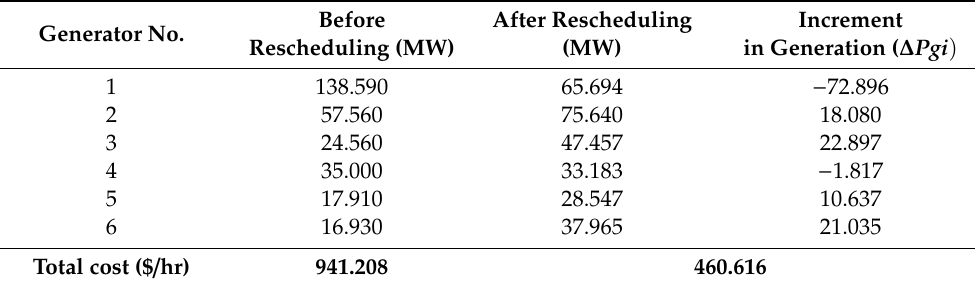
Table 4. Rescheduling of generators in the modified IEEE 30-bus